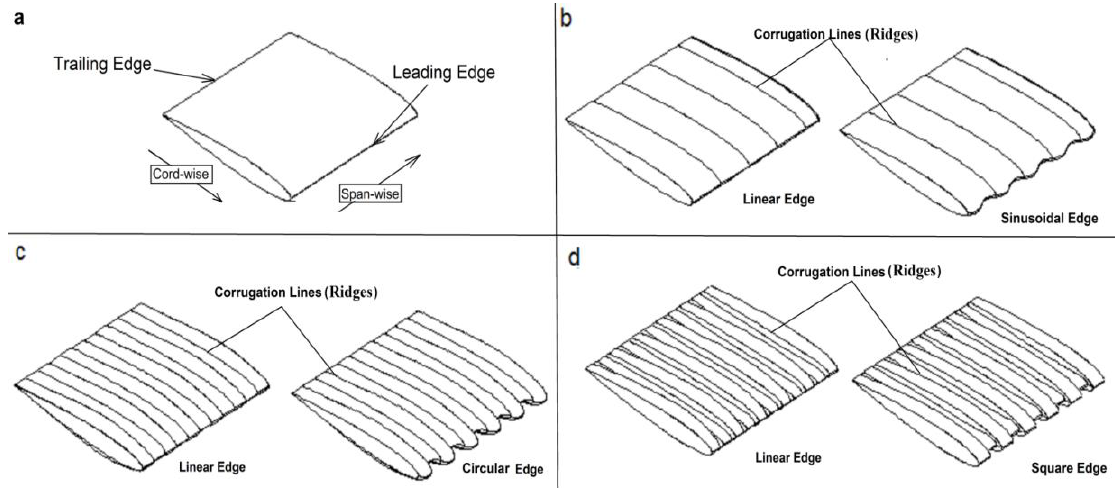
Figure 1. The state of art of the corrugated flexure hinges. ( a ) NACA 0012 Airfoil without corrugations, ( b ) sinusoidal profile corrugations, ( c ) circular profile corrugations, ( d ) square profile corrugations.